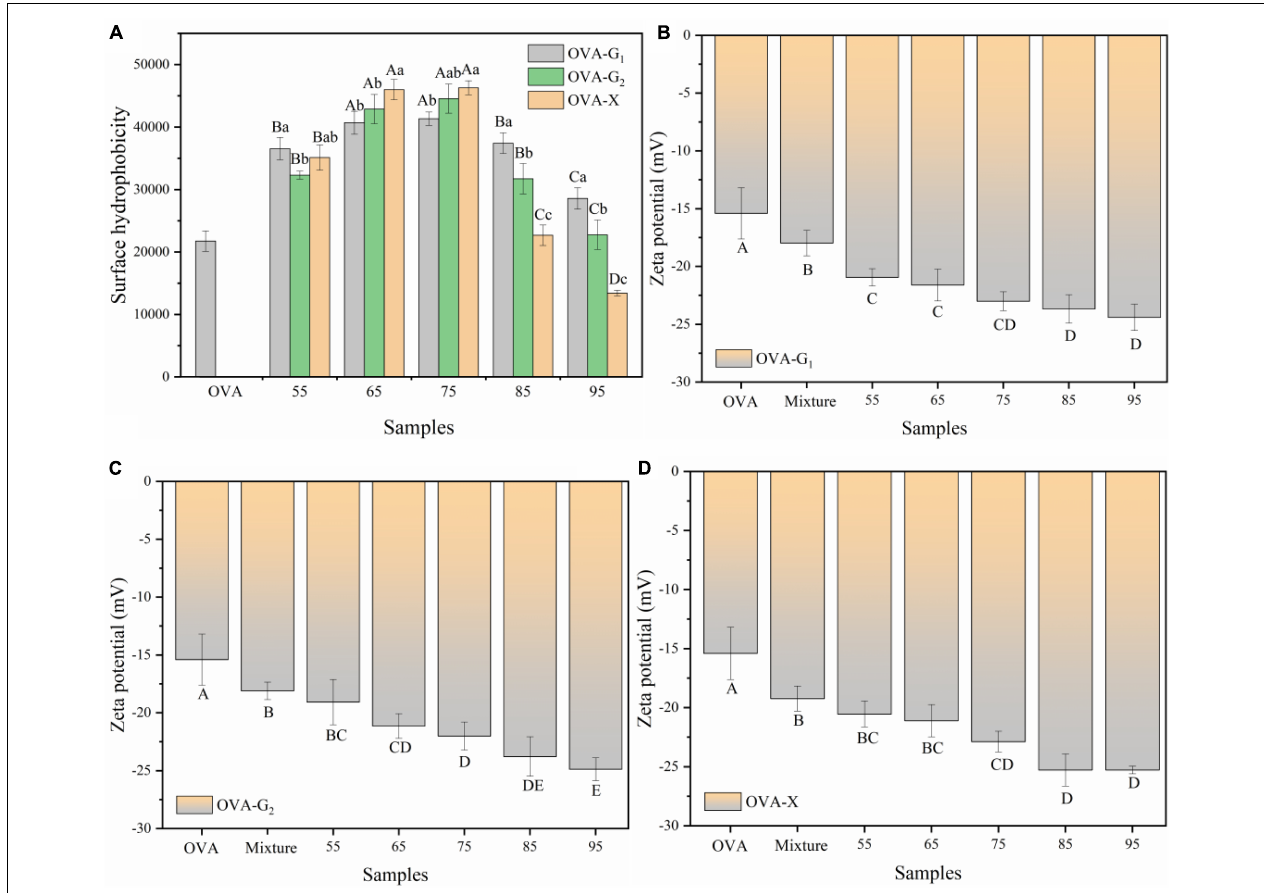
FIGURE 4 | Surface hydrophobicity (A) and zeta-potential (B–D) of OVA, OVA-G 1 , OVA-G 2 , and OVA-X at different reaction temperatures. Different lowercase letters indicate significant differences ( P < 0.05) between OVA-monosaccharide conjugates of different sugar types. Different capital letters indicate significant differences ( P < 0.05) in OVA, Mixture, and OVA-monosaccharide conjugates formed at different reaction temperatures.